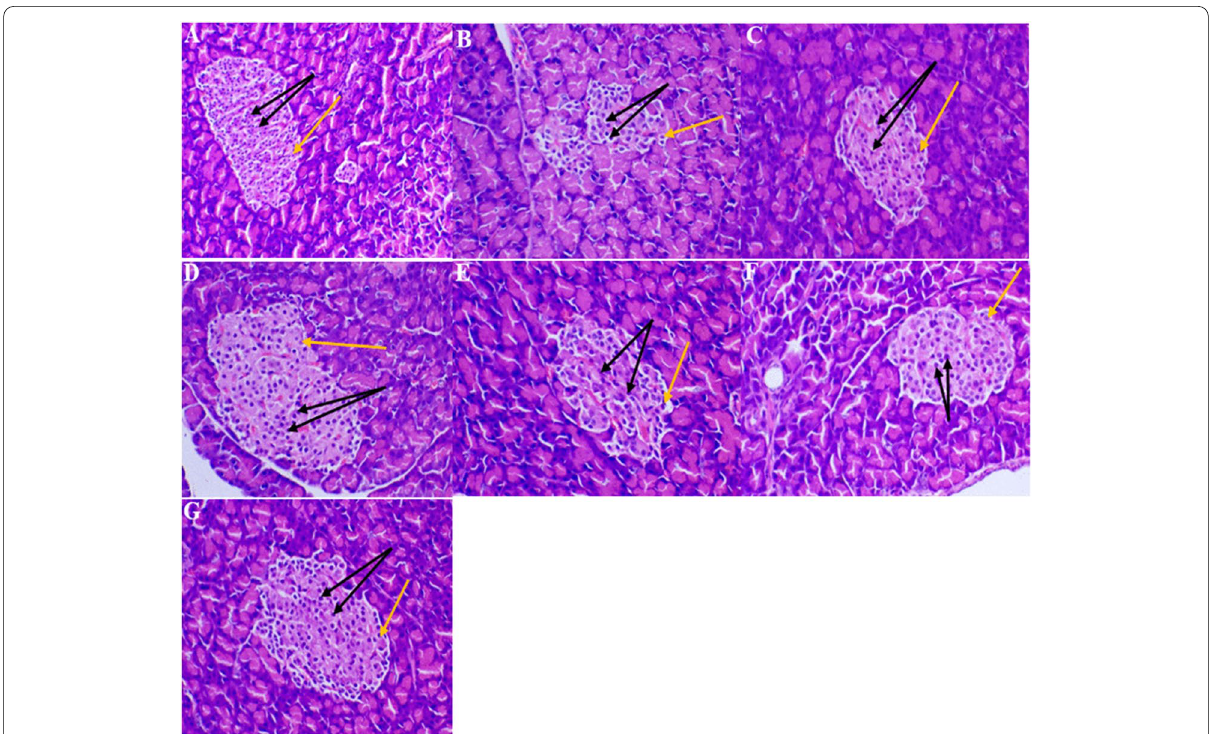
Fig. 7 Hematoxylin and Eosin (H&E) Photomicrographs ( 40 magnification) representing pancreatic Islet cells from the various treatment groups. × The double‑arrowed lines point to the β‑cells while the single‑arrowed lines point to the non‑β